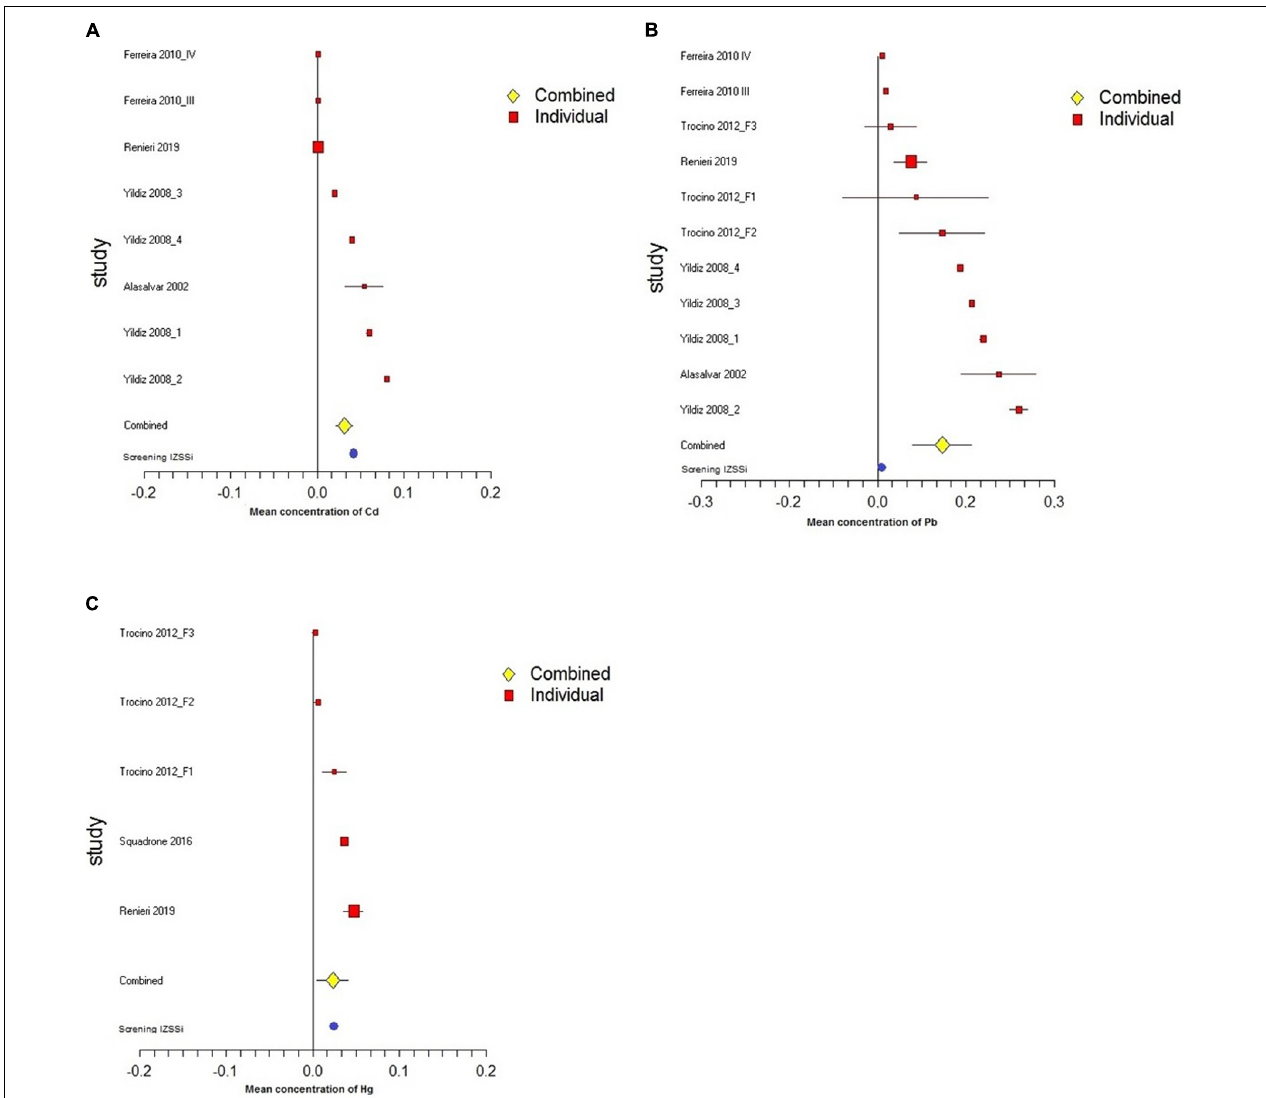
FIGURE 2 | Forest plot of meta-analysis of concentration of (A) Cd, (B) Pb, and (C) Hg. Solid diamonds and horizontal lines indicate the study-specific mean concentrations ( µ g g - 1 w.w.) and 95% CIs. The size of the area reflects the study-specific statistical weight. The vertical solid line shows the mean effect of